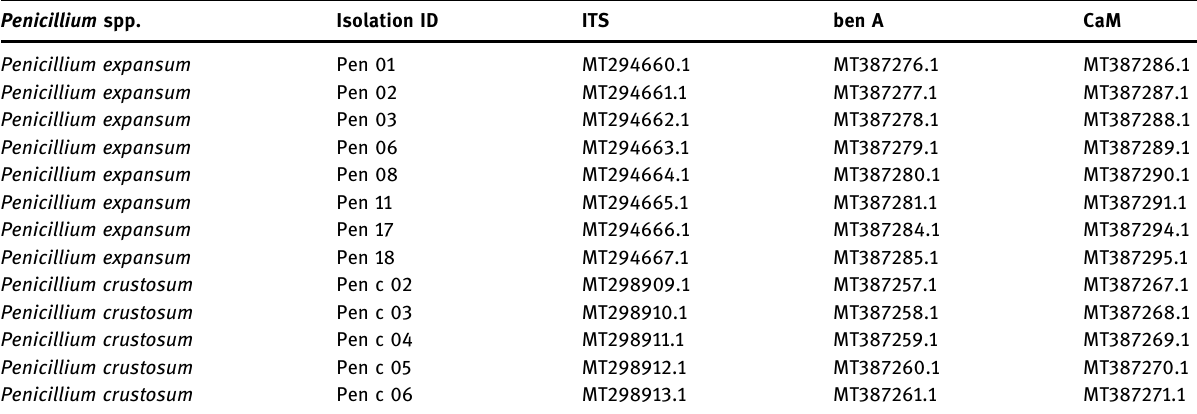
Table 4: Accession numbers of ampli fi ed nucleotide sequences from Penicillium spp. isolates Penicillium